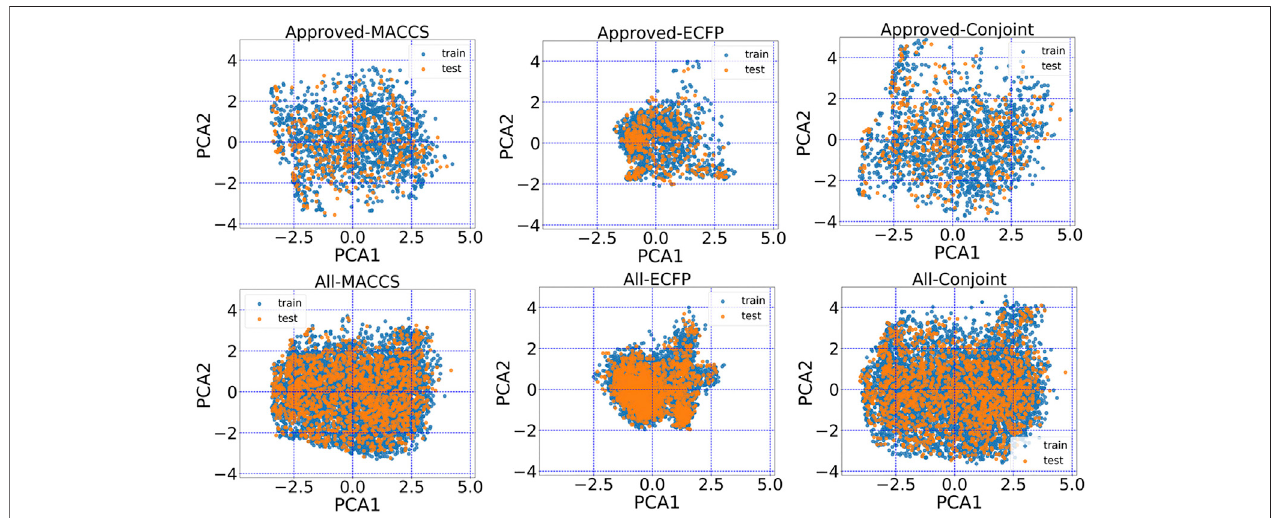
FIGURE 3 | The principal component analysis plot of the fi rst two principal components based on MACCS keys, ECFP and the conjoint fi ngerprint.